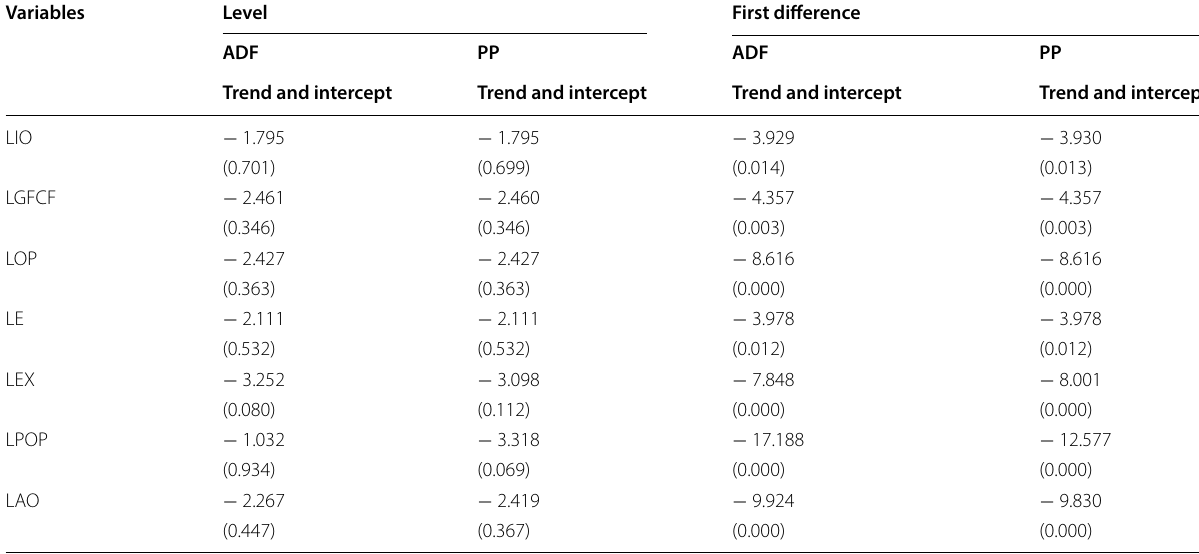
Table 1 Result of unit root test Source : Computed from secondary data Variables